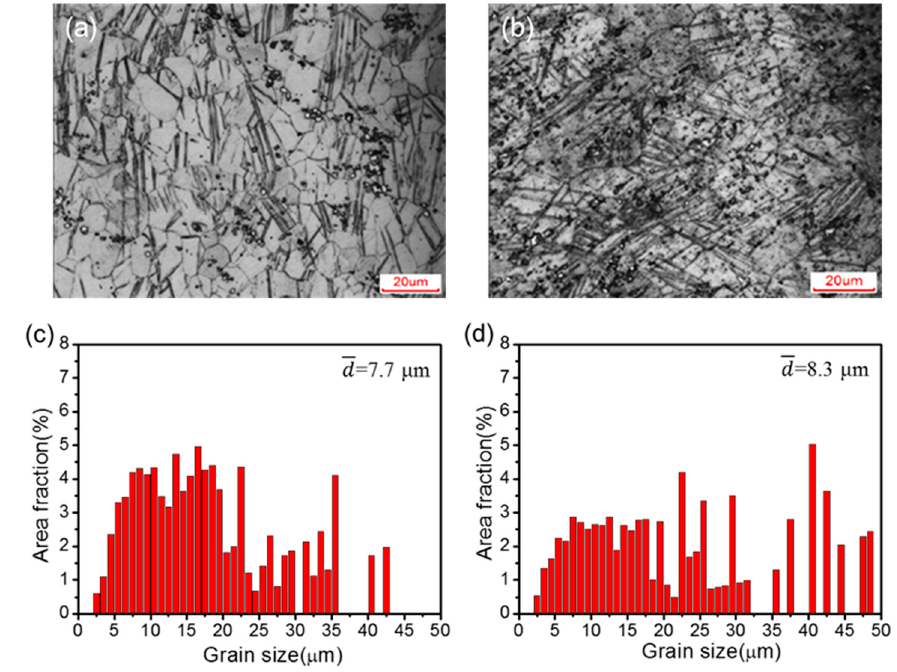
Figure 6. ( a , b ) Optical micrographs and ( c , d ) grain area distributions of ( a , c ) C-ECAP + R rolled alloy and ( b , d ) H-ECAP + R rolled alloy.